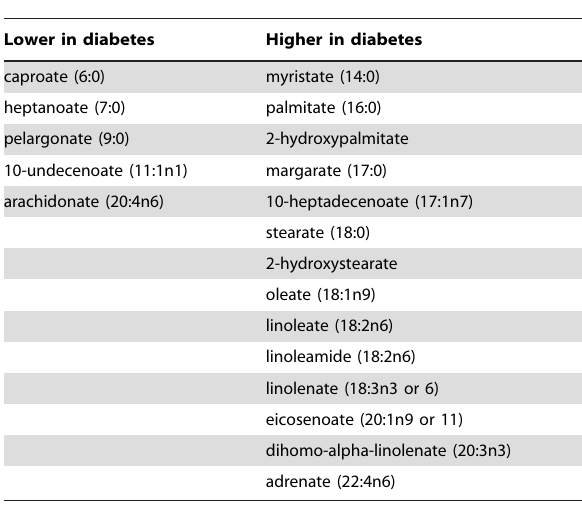
Table 4. Medium chain-length fatty acids and arachidonate are on average lower in the diabetes group, while long chain fatty acids are higher; shown are all fatty acids that associate with diabetes in at least one ratio pair combination with a q-value , 5% and a p-gain .